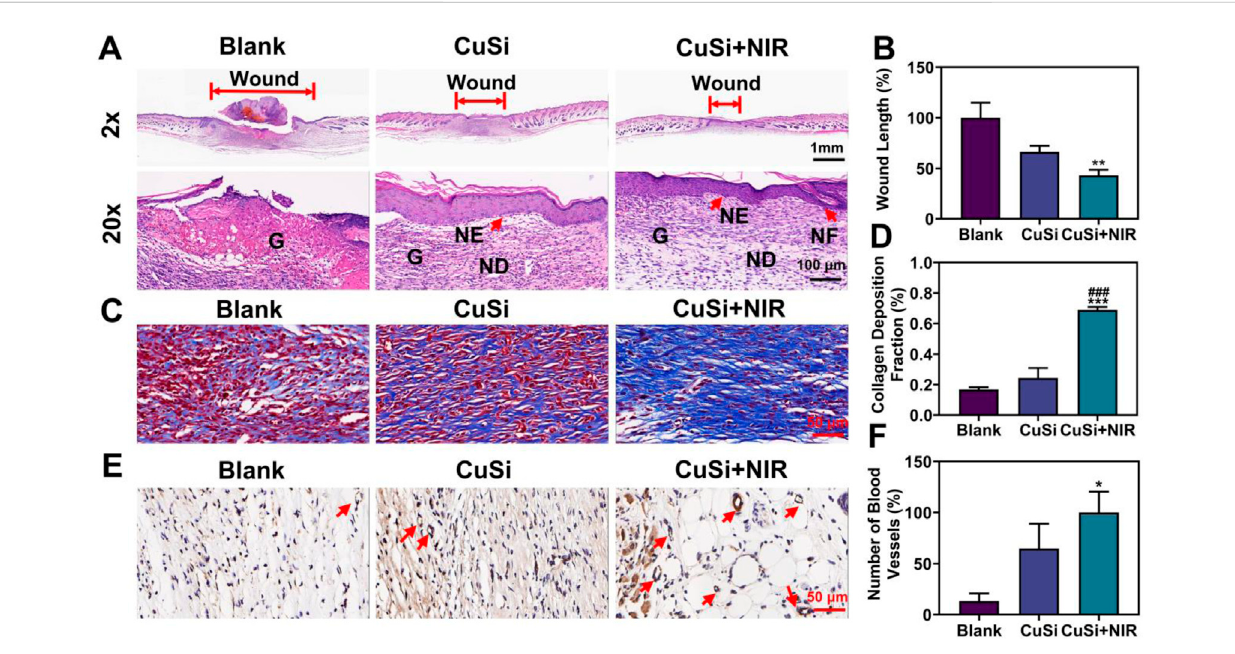
FIGURE 7 Histological analysis of wound sections after 9 days with different treatments. (A) H&E staining. The length of the red arrow represents the length of the unhealed wound bed (G: granulation tissue; NE: neoepidermis; ND: neodermis; HF: hair follicles). (B) Statistics of wound bed granulation length ( n = 5). The Blank group was normalized. (C) Masson staining. (D) Statistics of collagen deposition distribution ( n = 5). (E) Immunohistochemical staining pictures against CD31 and (F) the statistics ofneovessel numbers ( n = 5). The CuSi + NIR group was normalized in (F) . Arrows indicate blood